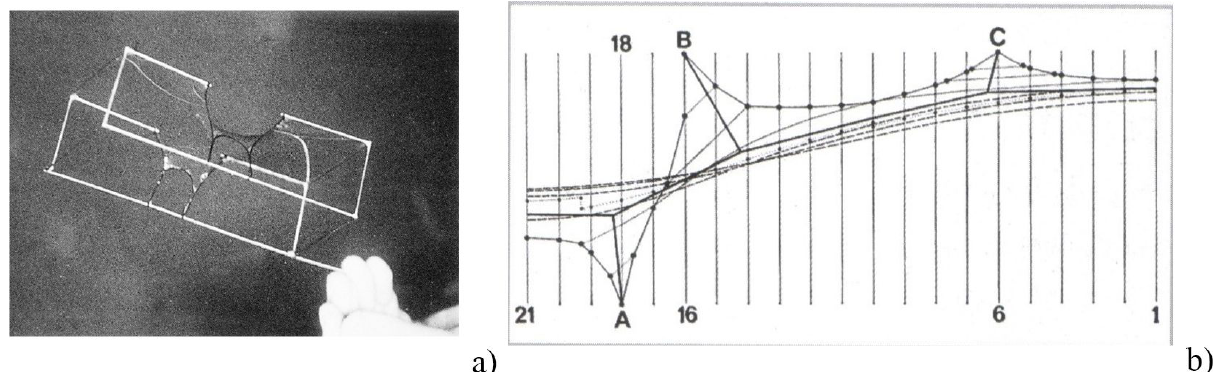
Figure 2: Form-finding of the Basento Bridge, (a) using soap bubbles; (b) integrating the membrane equation by finite differences